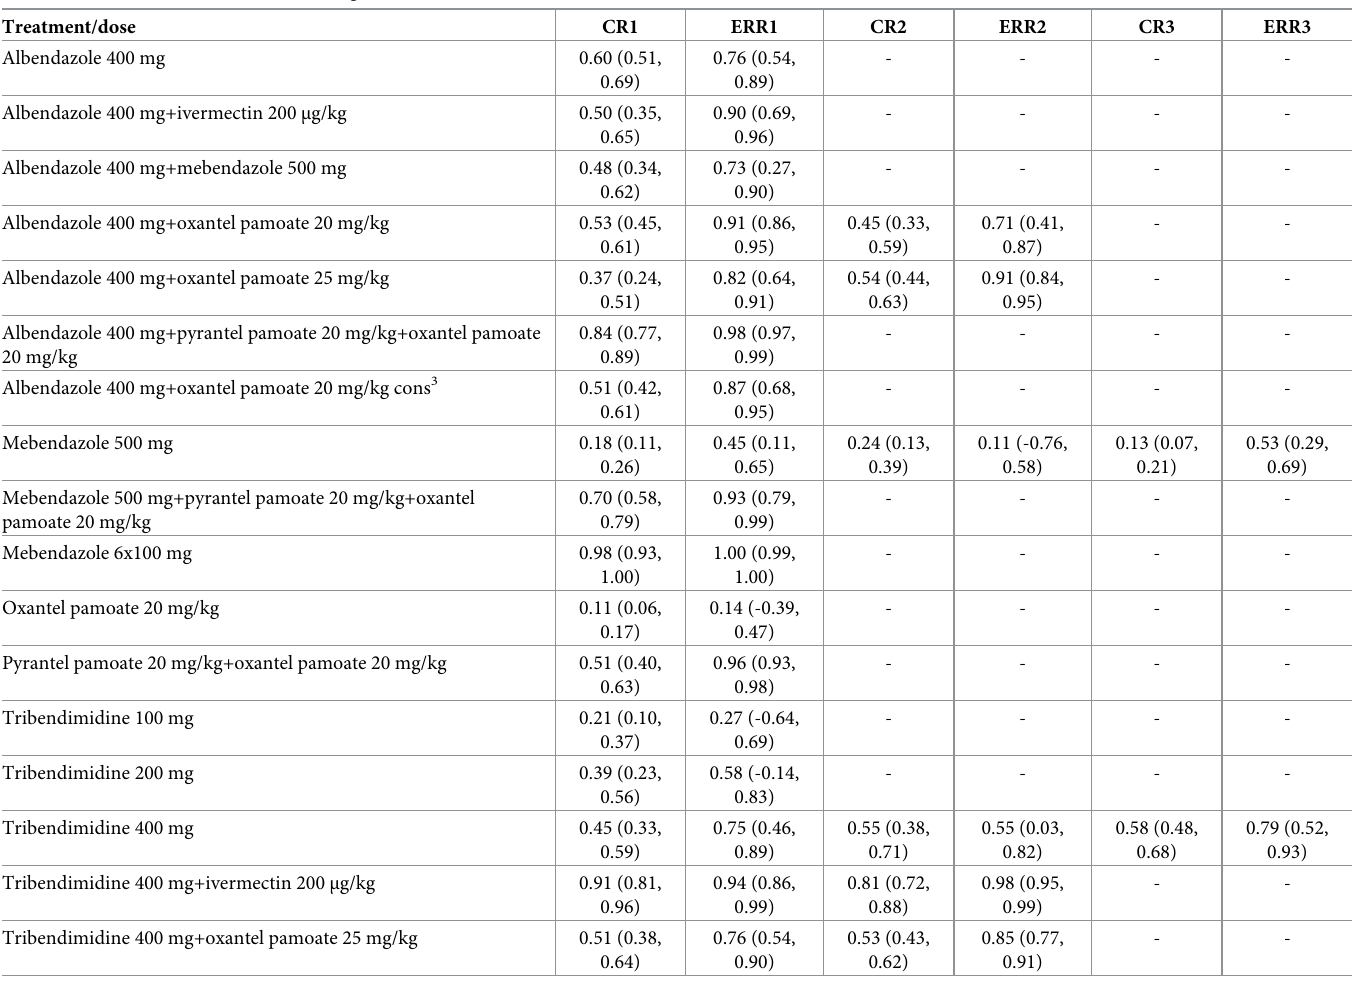
Table 3. Estimates of CRs and ERRs among different trials obtained from raw